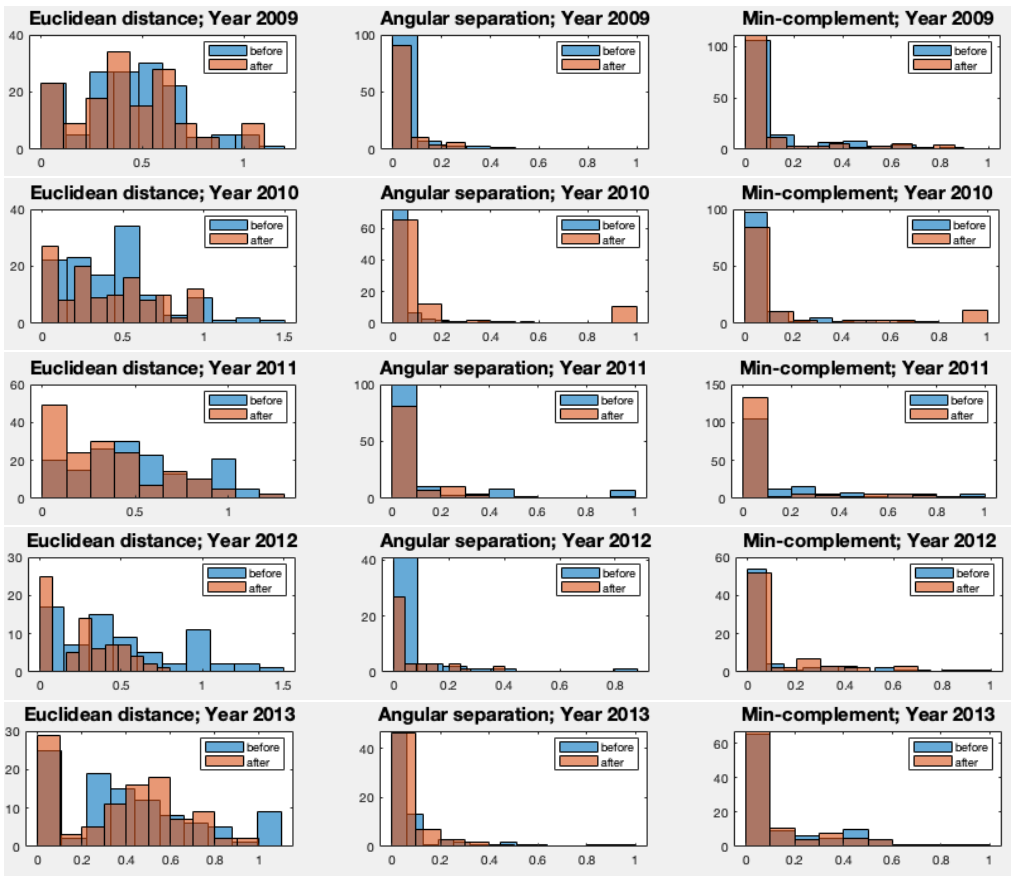
Fig. 2. Distribution of distance measures before and after joint patent application (skewed)